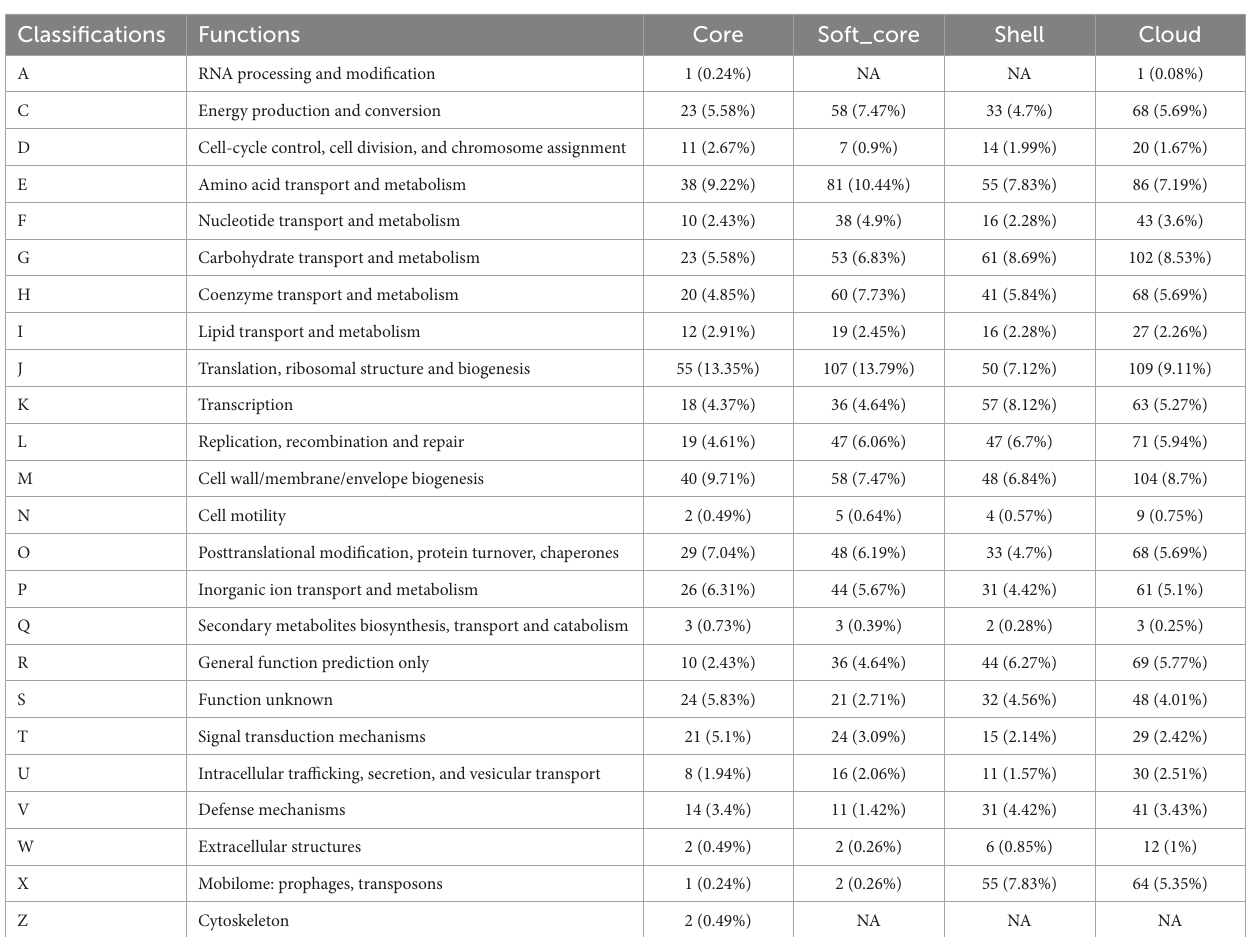
TABLE 4 COG annotation of the core genome and the accessory genome.